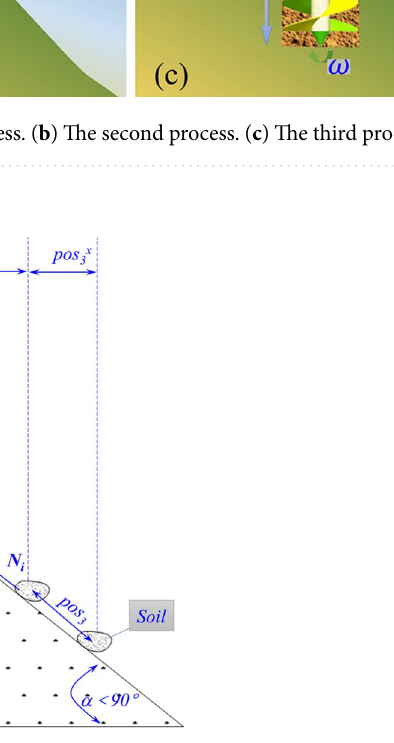
Figure 4. Schematic diagram of soil throwing